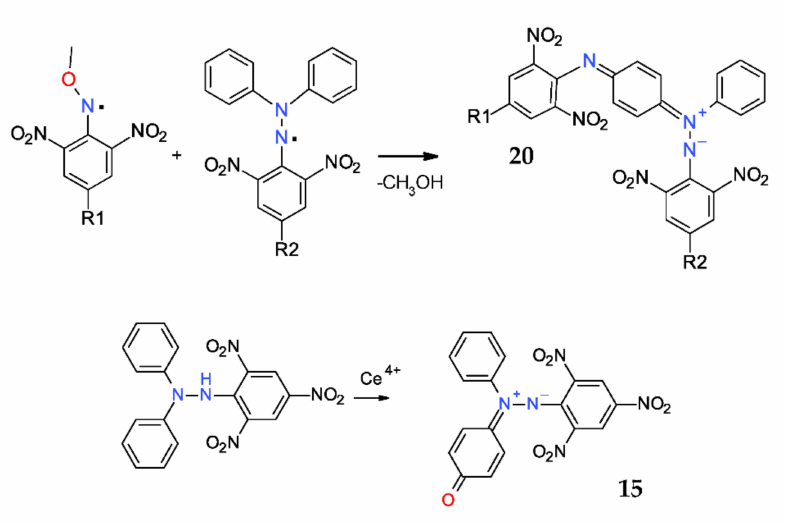
Figure 11. Synthesis of betaines 15 and 20.